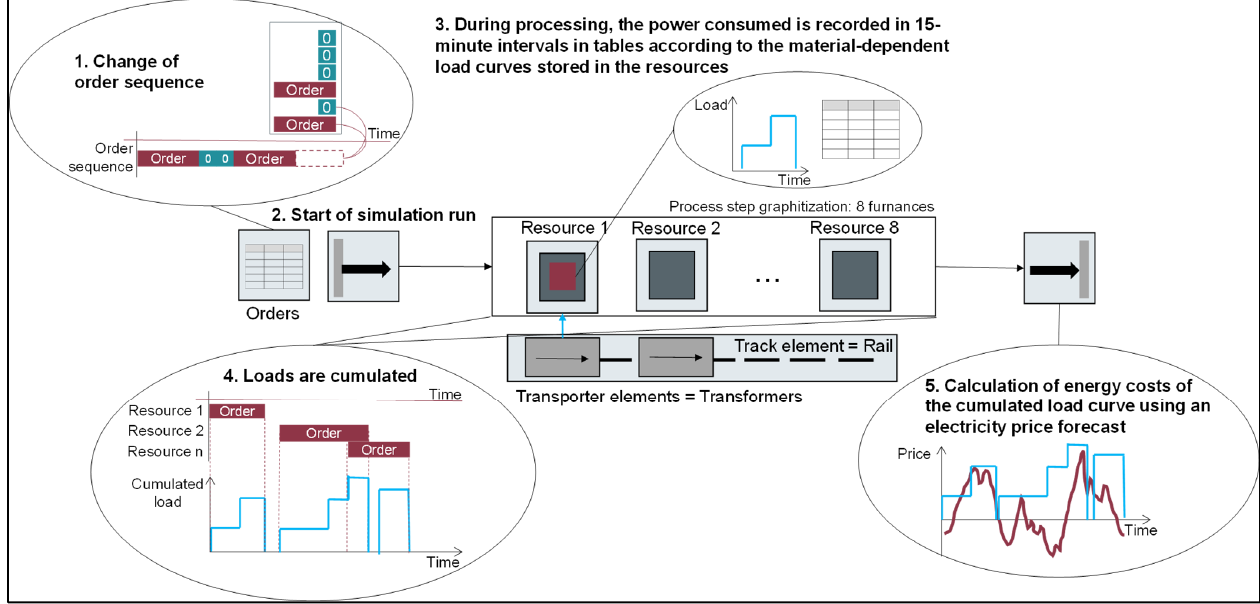
Figure 4. Schematic representation of the material and energy flows in use case 1.